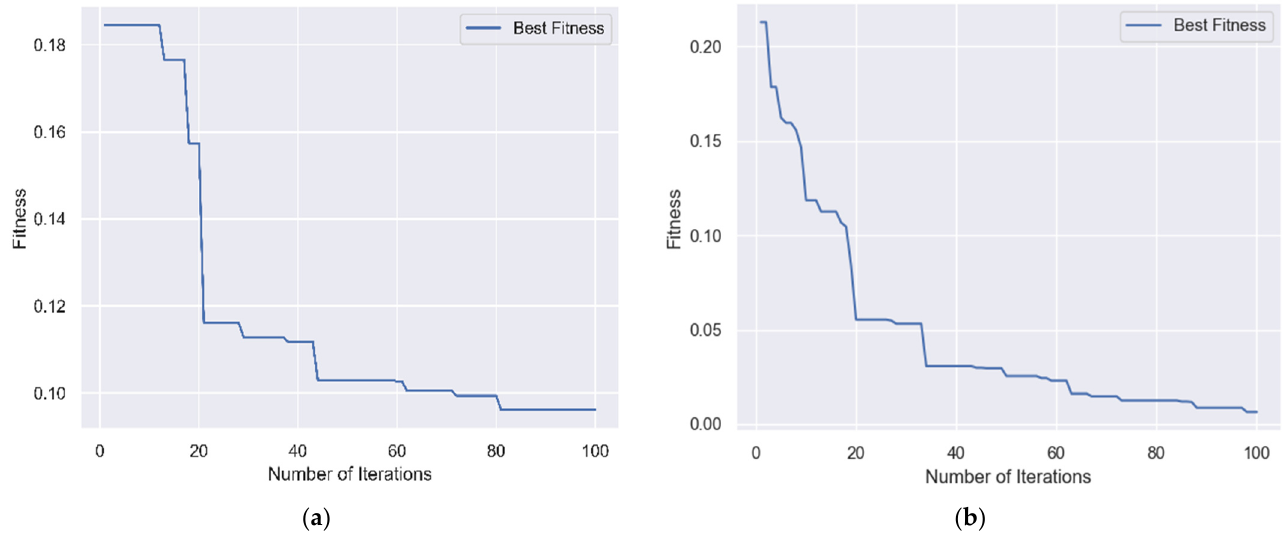
Figure 9. Loss curves of Genetic Algorithm. ( a ) Applying stator current signal ( I 2 ) ; ( b ) Applying the vibration signal. Table 6. Number of selected features.